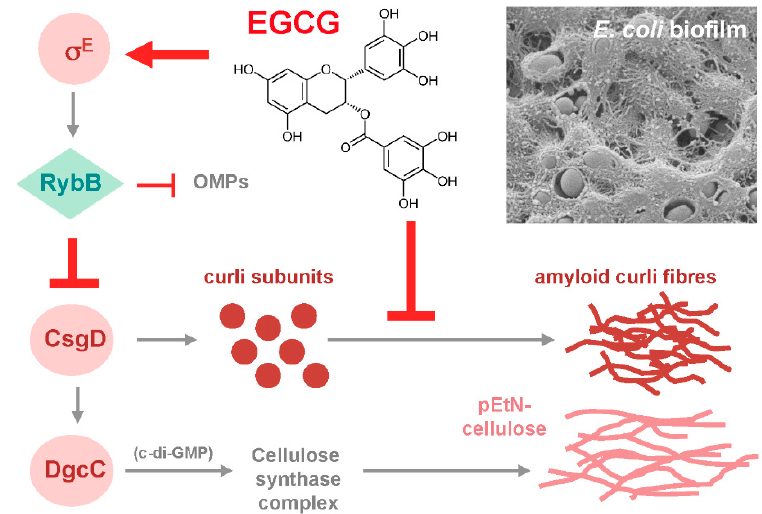
Figure 2. Summary of the mechanisms of action of EGCG on E. coli macrocolony biofilms. EGCG interferes with the production of both amyloid curli fibres and pEtN-cellulose fibril—which together form the fibrous matrix material visible in the scanning electron micrograph of the surface of an E. coli macrocolony biofilm shown in the upper right corner—by two separate but synergistically acting processes: (i) EGCG directly interferes with the formation of amyloid fibres from curli subunits; and (ii) EGCG induces the σ E (RpoE)-mediated cell envelope stress response, which drives increased synthesis of the small regulatory RNA RybB, which in turn reduces the expression of CsgD as well as of many outer membrane proteins (OMPs). The biofilm regulator CsgD is required for the expression of the curli subunits as well as of DgcC, the diguanylate cyclase that produces the second messenger c-di-GMP required to activate cellulose synthase as well as the associated phosphoethanolamin (pEtN) modification system. The figure was previously published [80] under the CC-NC-ND license; © the author.